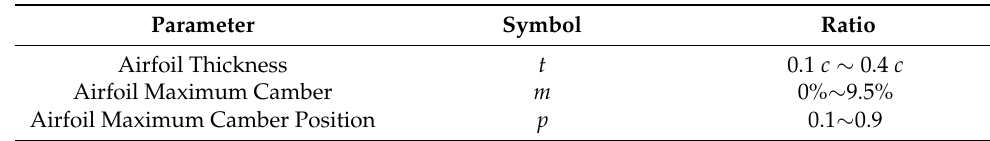
Table 1. The range of changes allowed in the determining components of the flap geometry during the optimization process